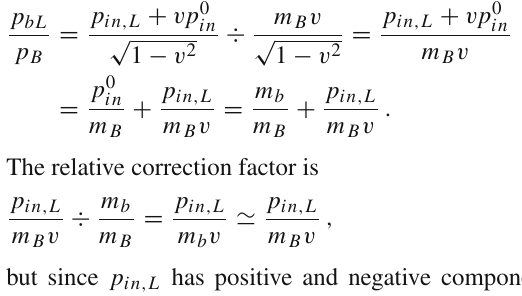
Fig. 5 The same as Fig. 4 but for different α